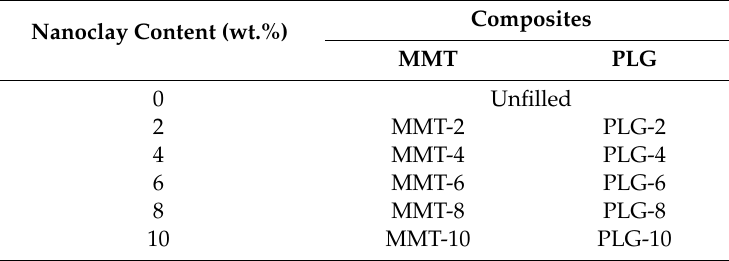
Table 1. Composition of dental